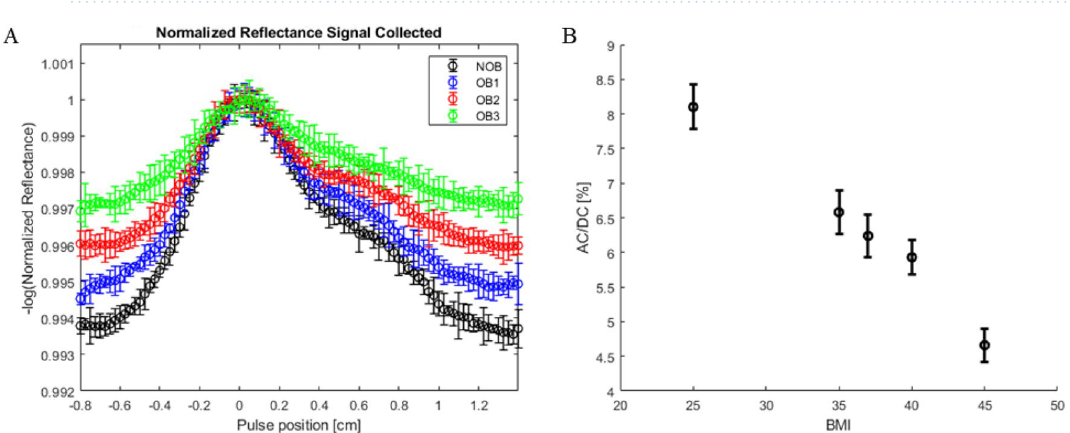
Figure 8. Variously generated waveforms at 660 nm for different photon counts and different geometry representative of BMI change. ( A ) Non-obese waveform generated at 100 million photons and 15 trials. ( B ) Non-obese waveform generated at 1 billion photons and 5 trials. ( C ) Obese 1 waveform at 100 million photons and ( D ) 1 billion photons. ( E ) Obese 2 waveform at 100 million photons and ( F ) 1 billion photons. ( H ) Obese 3 waveform at 100 million photons and ( G ) 1 billion photons.